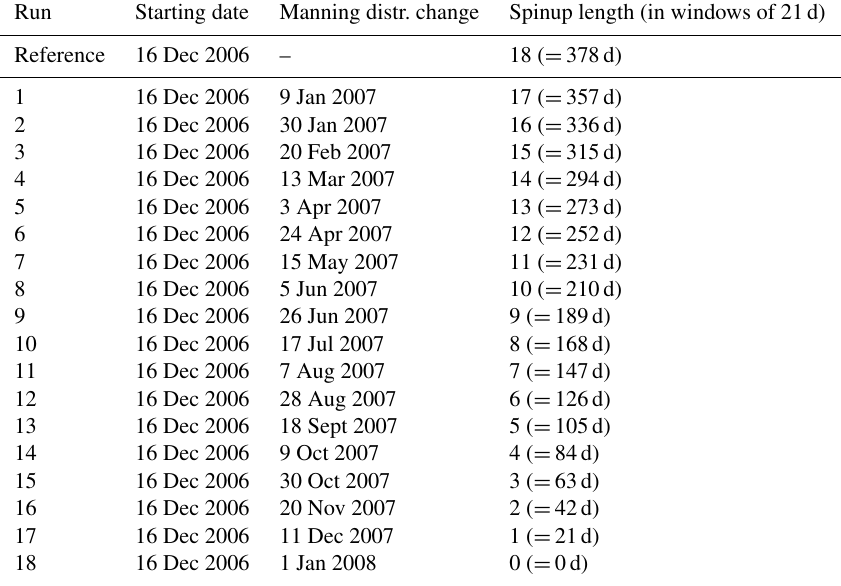
Table B1. Spinup sensitivity test setup: each run consists of an approximately 2-year long ISBA-CTRIP run starting on 16 December 2006 (column 2) and ending on 22 December 2008. After a given number of 21d windows during the first year (column 3), the Manning distribution is changed to replicate an assimilation update step, while the reference run (row 2) used the same Manning for the entire run. The period between the instant when the Manning distribution is changed and the beginning of the second year of simulation corresponds to the spinup period (column 4). The simulated water depth and discharge during the second year of the run are then compared to the reference run in order to evaluate the impact of the